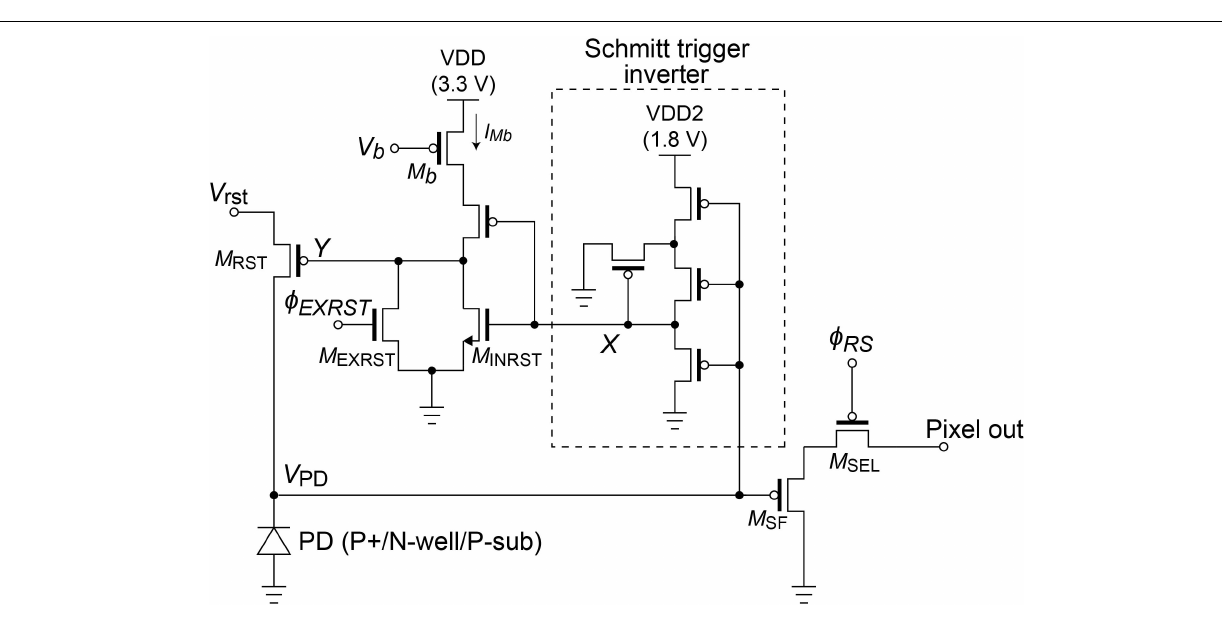
FIGURE 2 | Schematic of the self-reset pixel with a low-voltage driven Schmitt trigger inverter. The PD is composed of